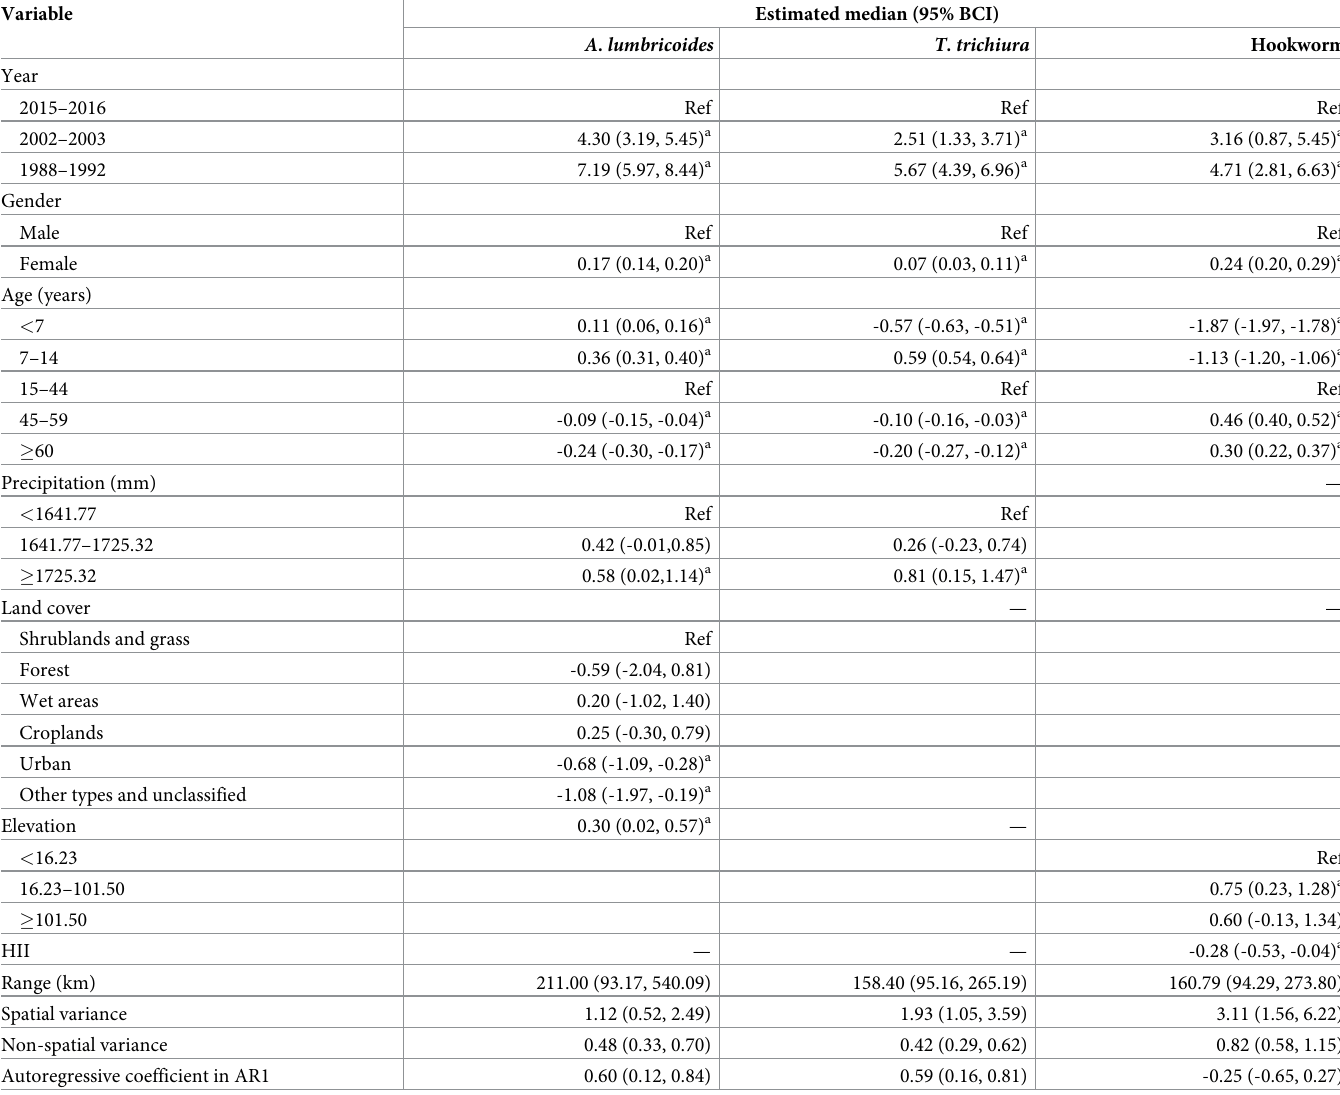
Table 3. Posterior summaries of the geostatistical model parameters for A . lumbricoides , T . trichiura , hookworm.